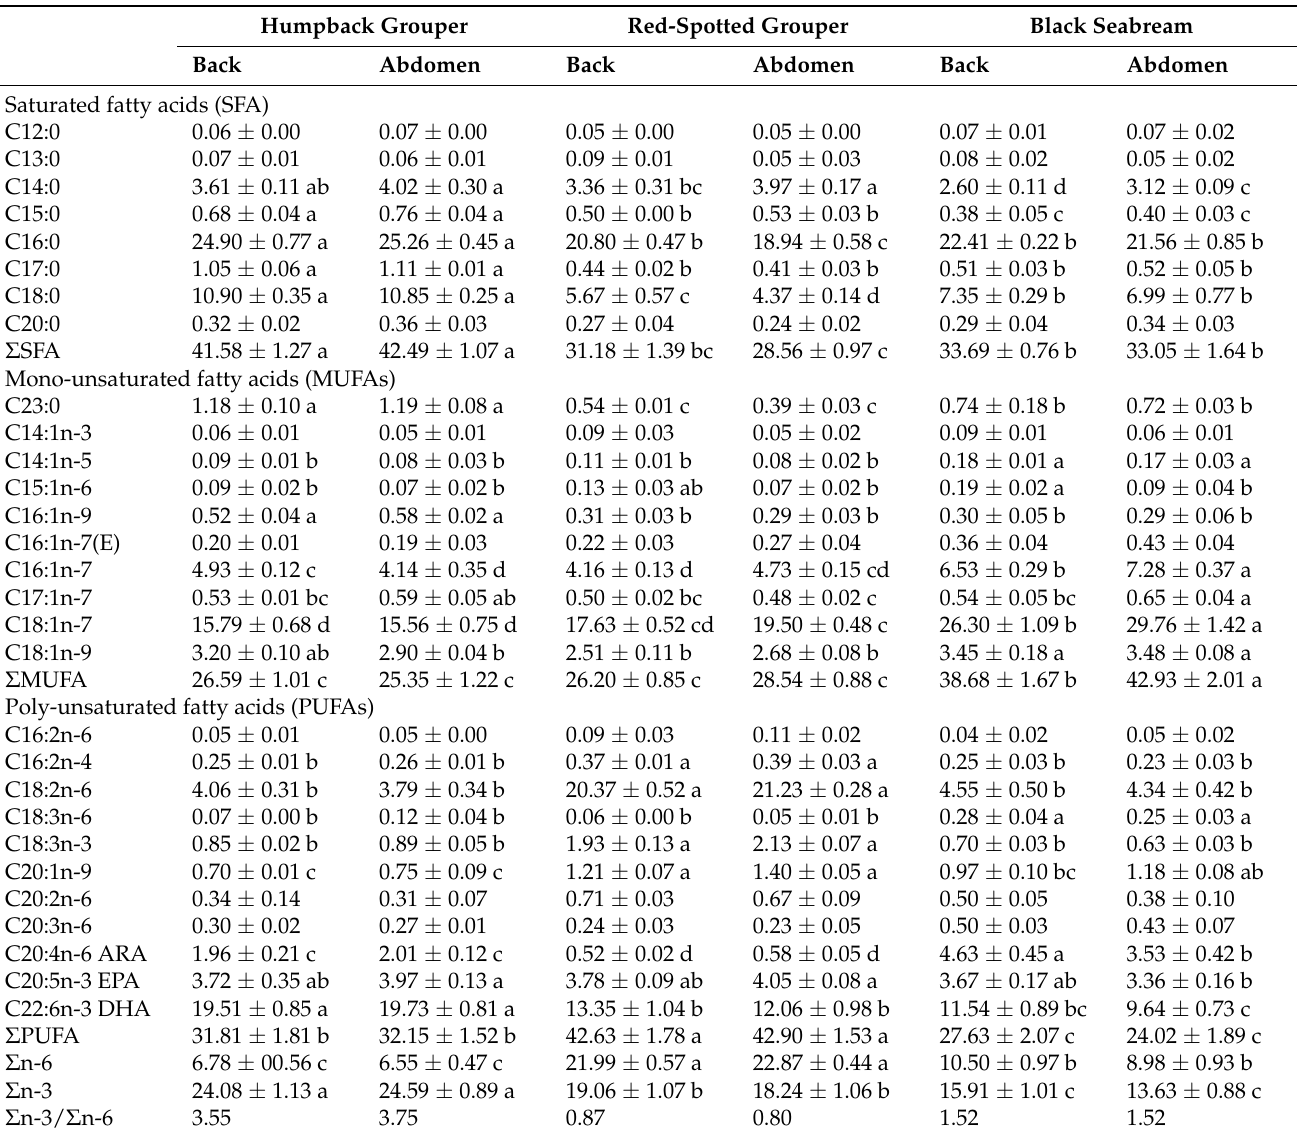
Table 2. Fatty acid profiles (%) of back and abdominal muscles in three perciforms fishes. Humpback Grouper Red-Spotted Grouper Black